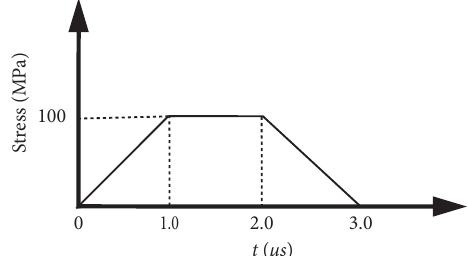
Figure 2: Dynamic stress waveforms on the